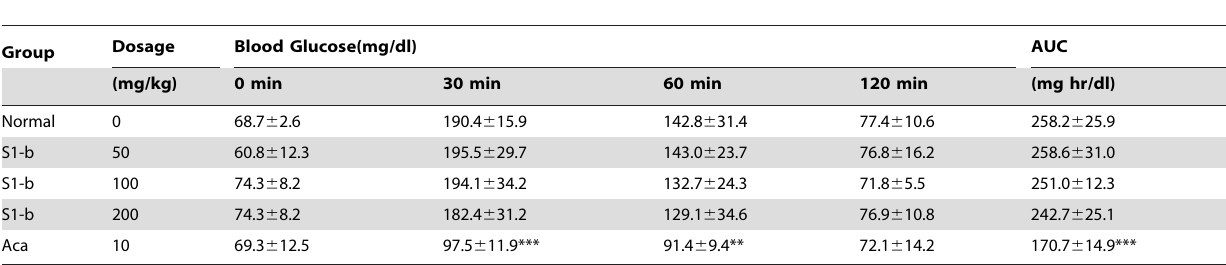
Table 3. The influence of S1-b and acarbose on blood glucose and area under curve (AUC) of normal ICR rat after sucrose loading (Student’s t test).